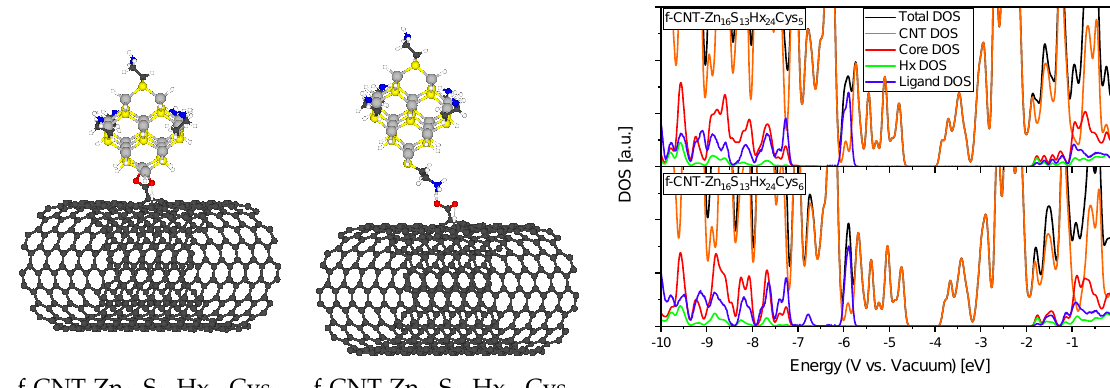
Figure 9. Relaxed structures of carboxylic functionalized CNT binding to Cysteamine terminated QDs (grey: Zn, yellow: S, white: Hx or H, black: C, red: O, blue: N) directly as passivating ligand ( left )